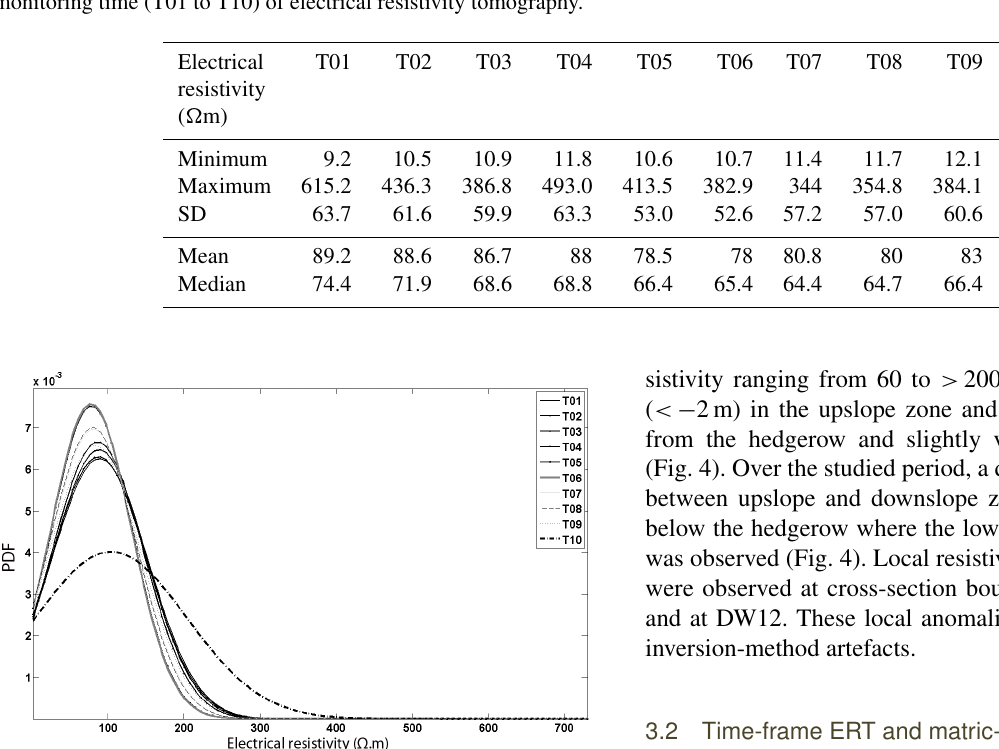
Table 2. Statistics of electrical resistivity measurements calculated from the 548 cells of the entire 2-D section (entire domain) at each monitoring time (T01 to T10) of electrical resistivity tomography.